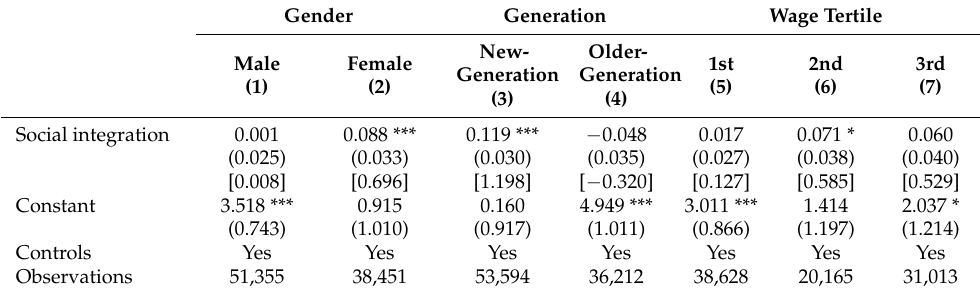
Table 5. Heterogeneous